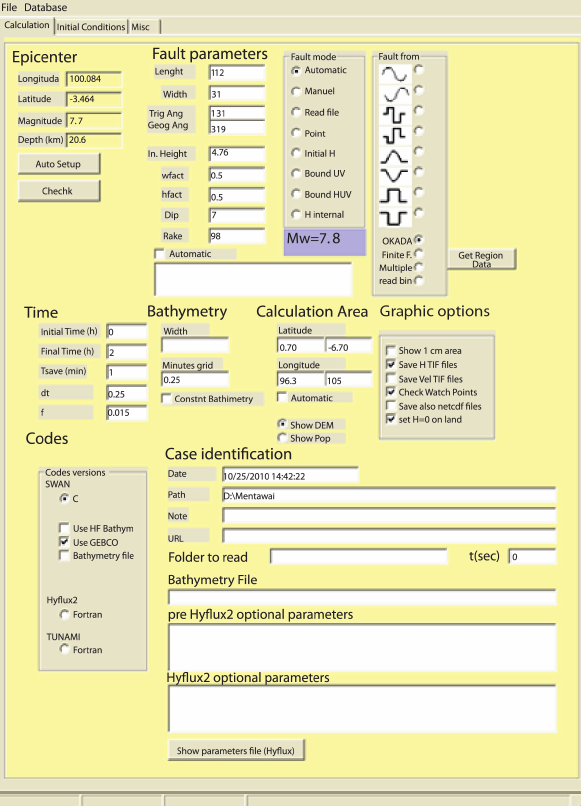
Fig. 12. Input window of the program